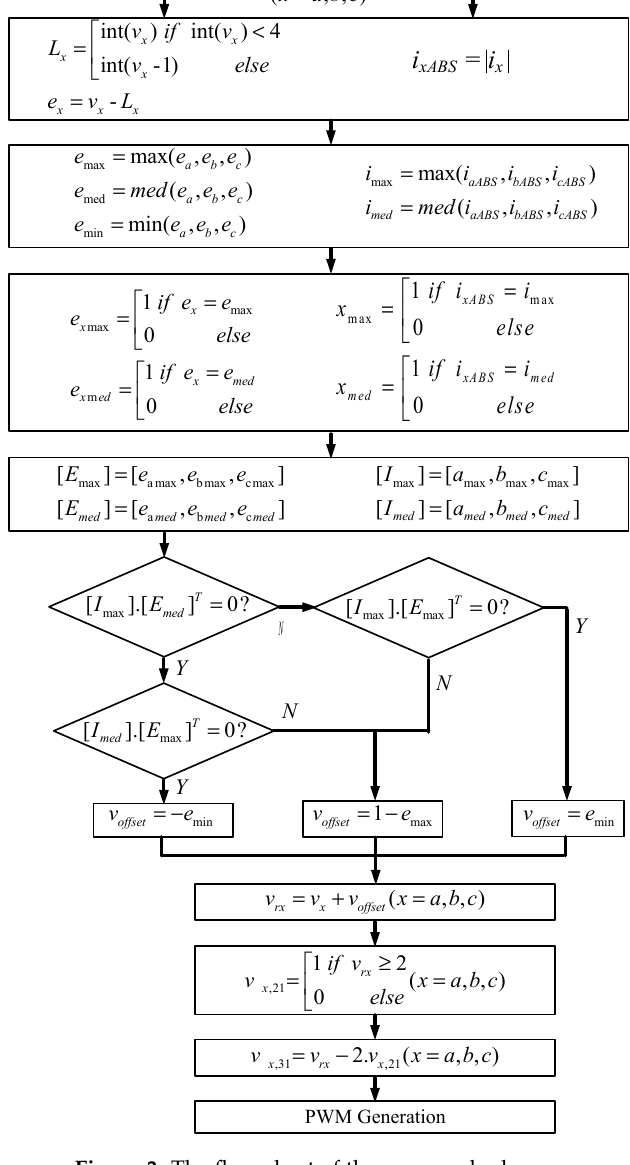
Figure 3. The flow chart of the proposed scheme.